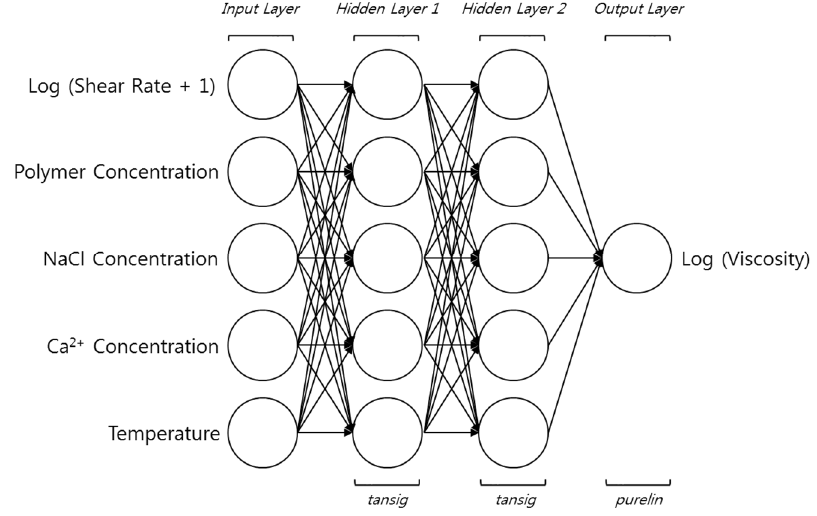
Figure 4. Structure of the artificial neural network (ANN)